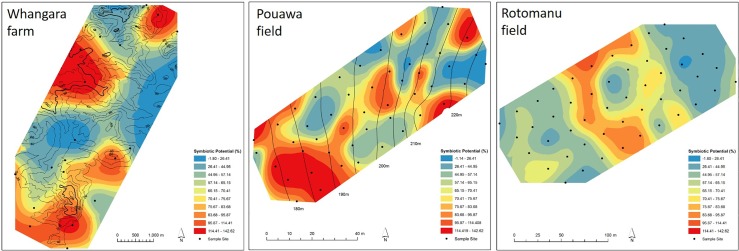
Spatial variation in Rhizobium leguminosarum bv. trifolii symbiotic potential (SP); i.e. efficacy at increasing the growth of Trifolium repens cv. Tribute.Assay conditions for clover growth had minimal nitrogen content, such that plant growth was directly related to N-fixation occurring through symbiosis. SP is calculated relative to growth of T. repens c.v Tribute inoculated with the current commercial R. leguminosarum bv. trifolii strain used in New Zealand, TA1 (= 100%). Black dots represent sampling spots based on GPS-marked points. Contour lines for Whangara and Pouawa are given; the field at Rotomanu had flat topography. Variation in SP between samples was assessed using the RBK method in ARC-GIS.